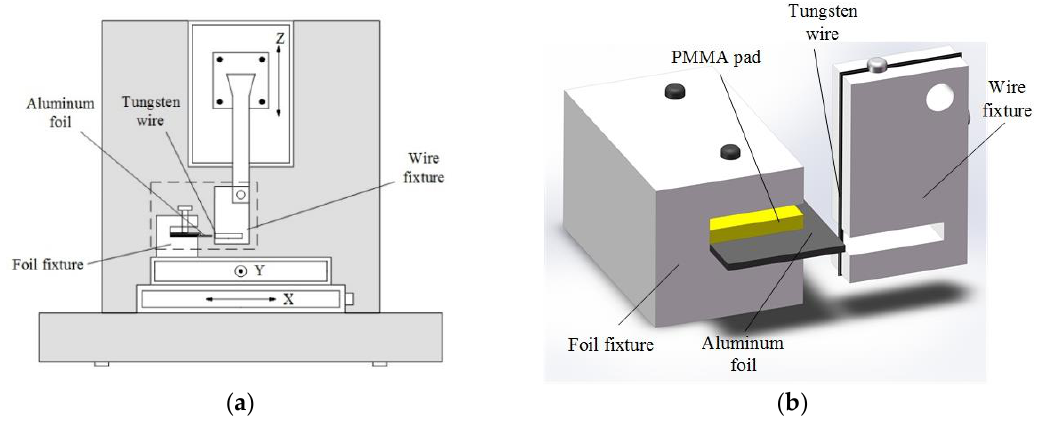
Figure 4. Experimental apparatus: ( a ) machining tool; ( b ) fixture enlargement.